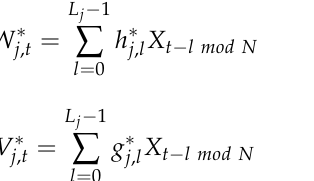
Figure 5. Structure and parameters for an artificial intelligence network.